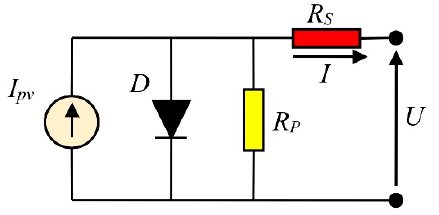
Figure 1. Equivalent circuit of the standard single-diode solar cell model.